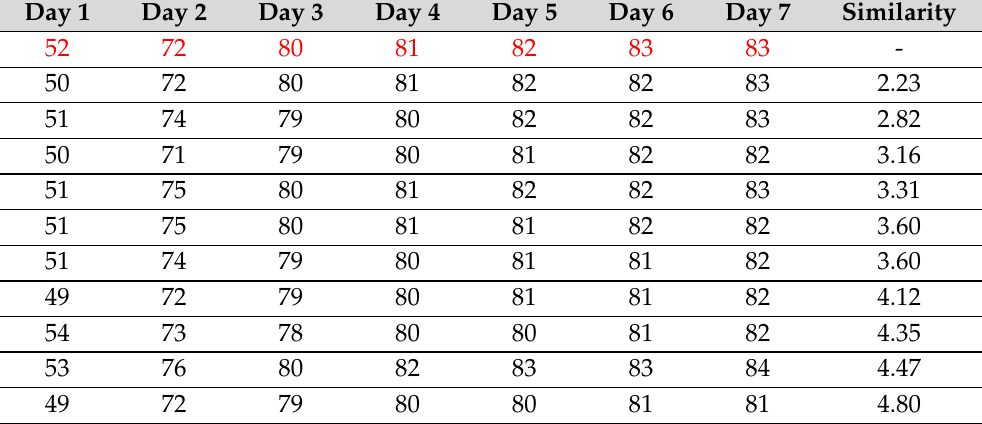
Table 3. Similarity between a target character and recommended characters in Table